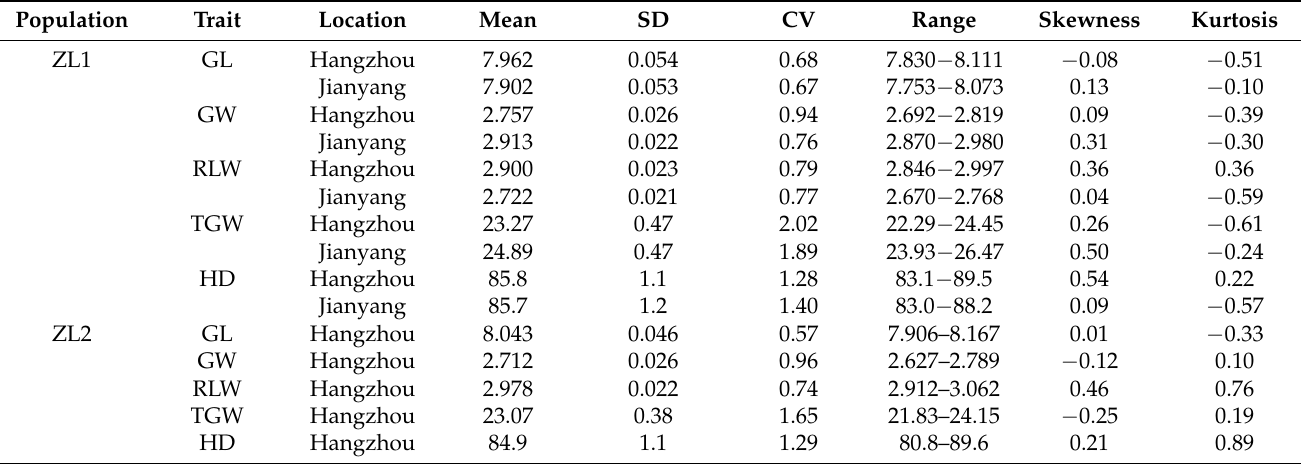
Table 1. Phenotypic performance of five traits in the ZL1 and ZL2